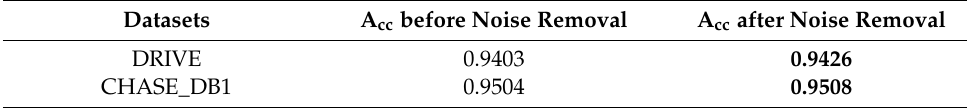
Table 8. Analysis of A cc performance indicator by removing